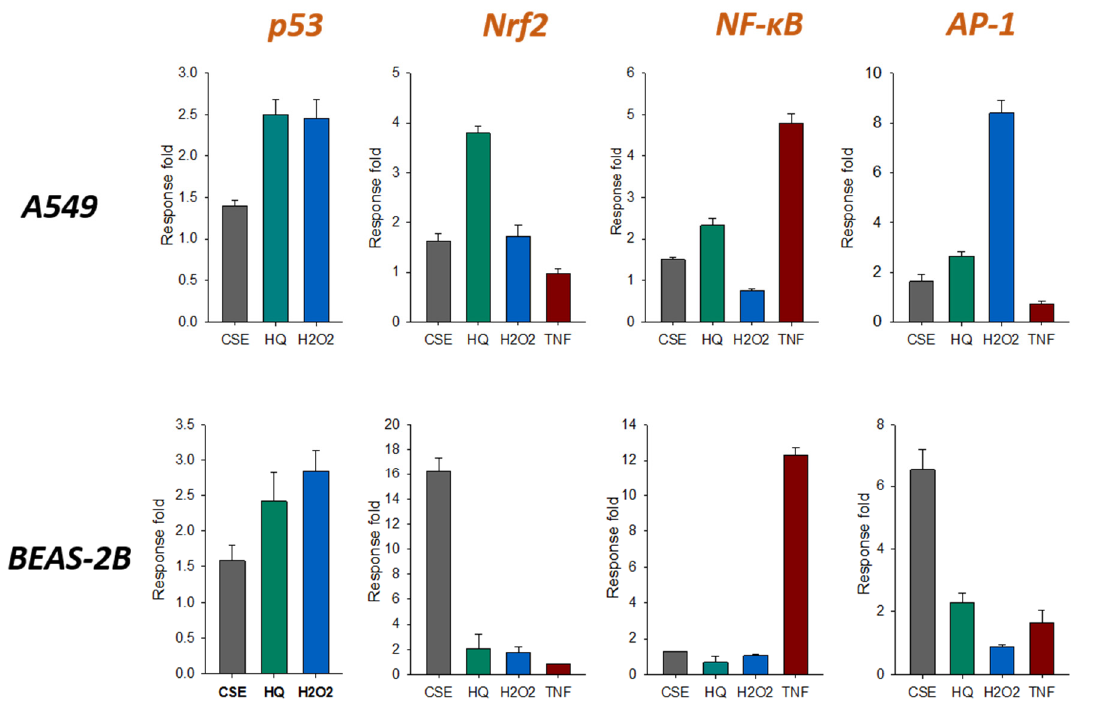
Figure 6. Induction of transcriptional activities of selected TFs in A549 and BEAS-2B cells by a cigarette smoke extract (CSE), hydroquinone (HQ), hydrogen peroxide, and Tumor Necrosis Factor (TNF). The response fold is measured as a ratio of luciferase activities in the treated and untreated cells after 18 h of exposure. The stressor concentrations are 2.5% CSE in both lines; 125 and 32 µ M HQ in A549 and BEAS-2B, respectively; 1000 and 125 µ M H 2 O 2 in A549 and BEAS-2B, respectively; 4 ng / mL TNF in both lines. The error bars are SDs; n = 3.